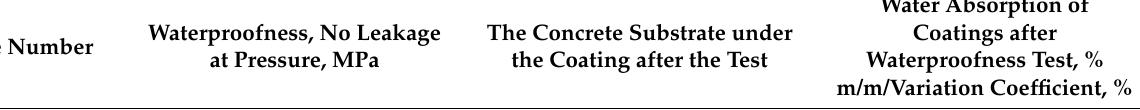
Table 5. Results of the test of water absorption of coatings and the assessment of their moisture level.